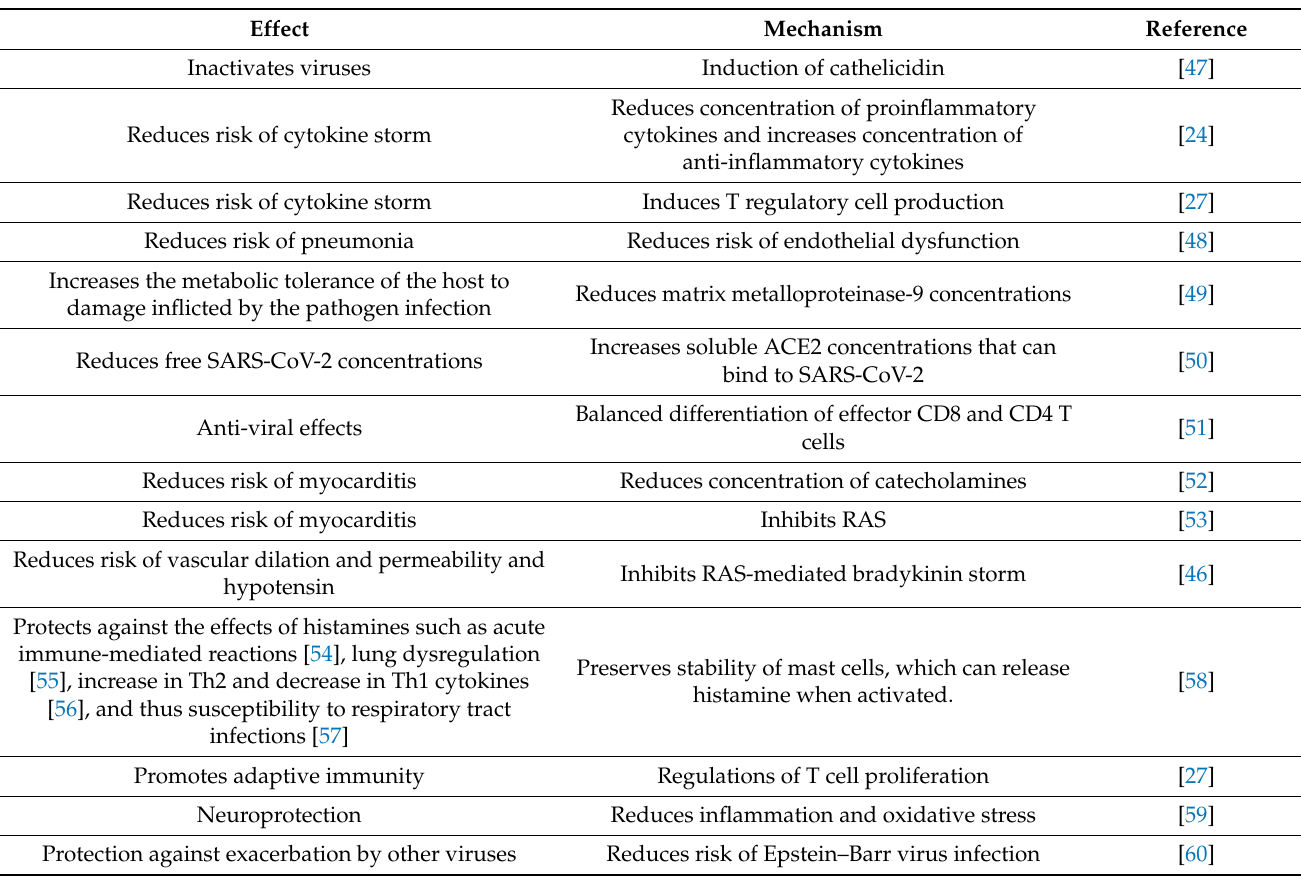
Table 1. Proposed mechanisms whereby vitamin D reduces risk of COVID-19 (note, order of mecha- nisms should be carefully considered, perhaps placing more important ones near the